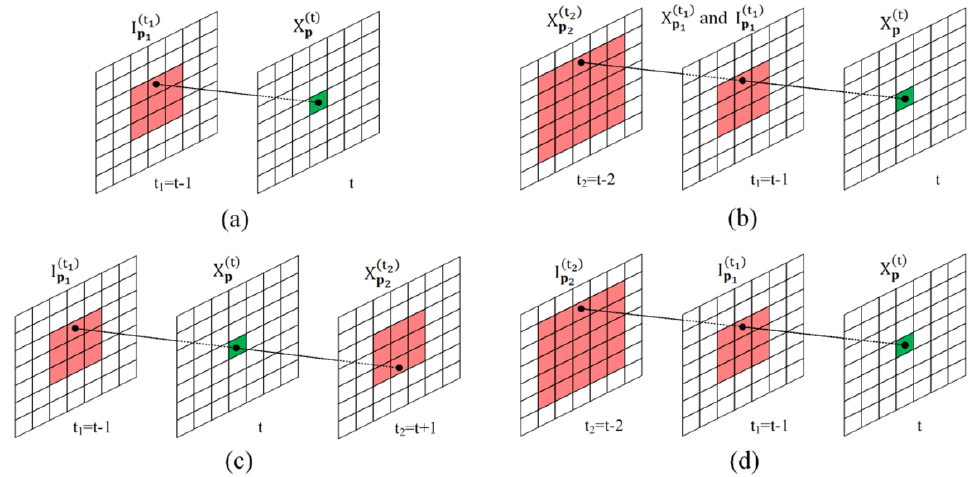
Figure 1. Sketchy diagram of the correlation between the observation data 𝑋 𝒑(𝑡) of the current frame (painted green) and the data of the other frames; the regions participating in the state transition decision process are represented in red. ( a ) First-order DP; ( b ) second-order DP with the correlation with the observation data of the previous two frames; ( c ) second-order DP with backtracking; ( d ) MFF-DP. A point target moves at a speed not greater than 𝑣 max = 1 pixel/frame.